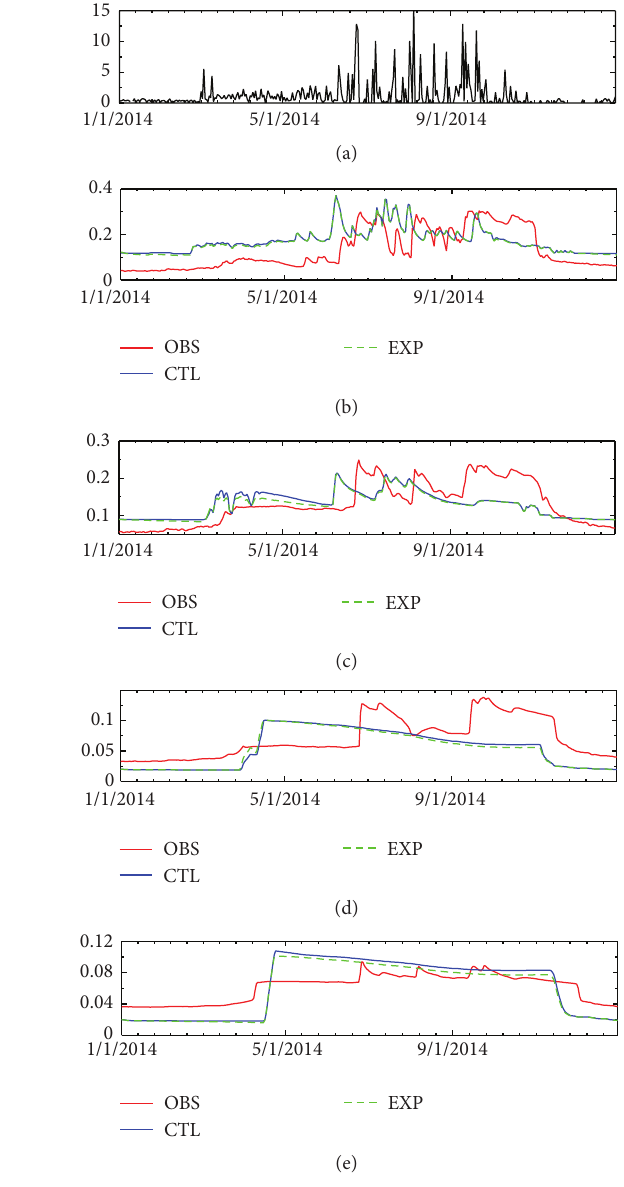
Figure 5: Same as Figure 4 but at GS